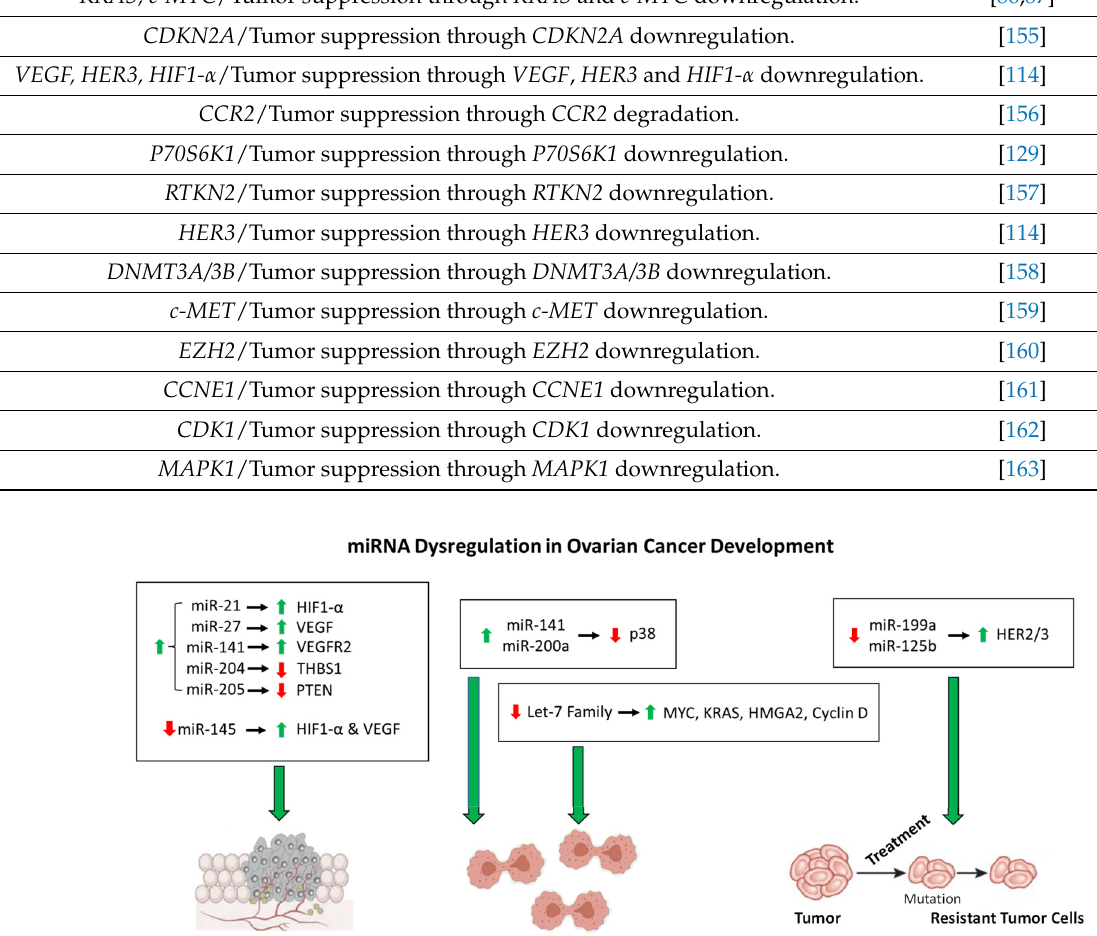
Figure 1. The roles of miRNA dysfunction in OC development. As described in the text, the miRNAs shown above are dysregulated in OC that contribute to angiogenesis, cell proliferation, and therapeutic resistance. The dysregulation of each miRNA is denoted by an up arrow (upregulation) or a down arrow(downregulation). The regulation of proteins affected by the dysregulation miRNAs is denoted in the same manner.